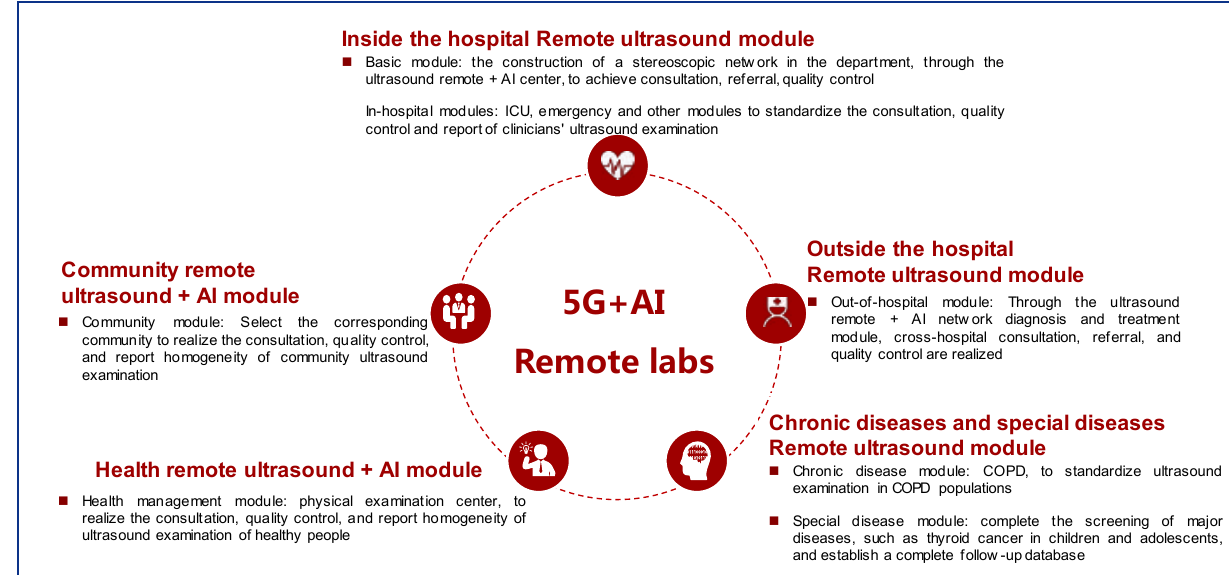
Figure 2 The construction of 5G and AI-integrated remote laboratories within and beyond the hospitals in